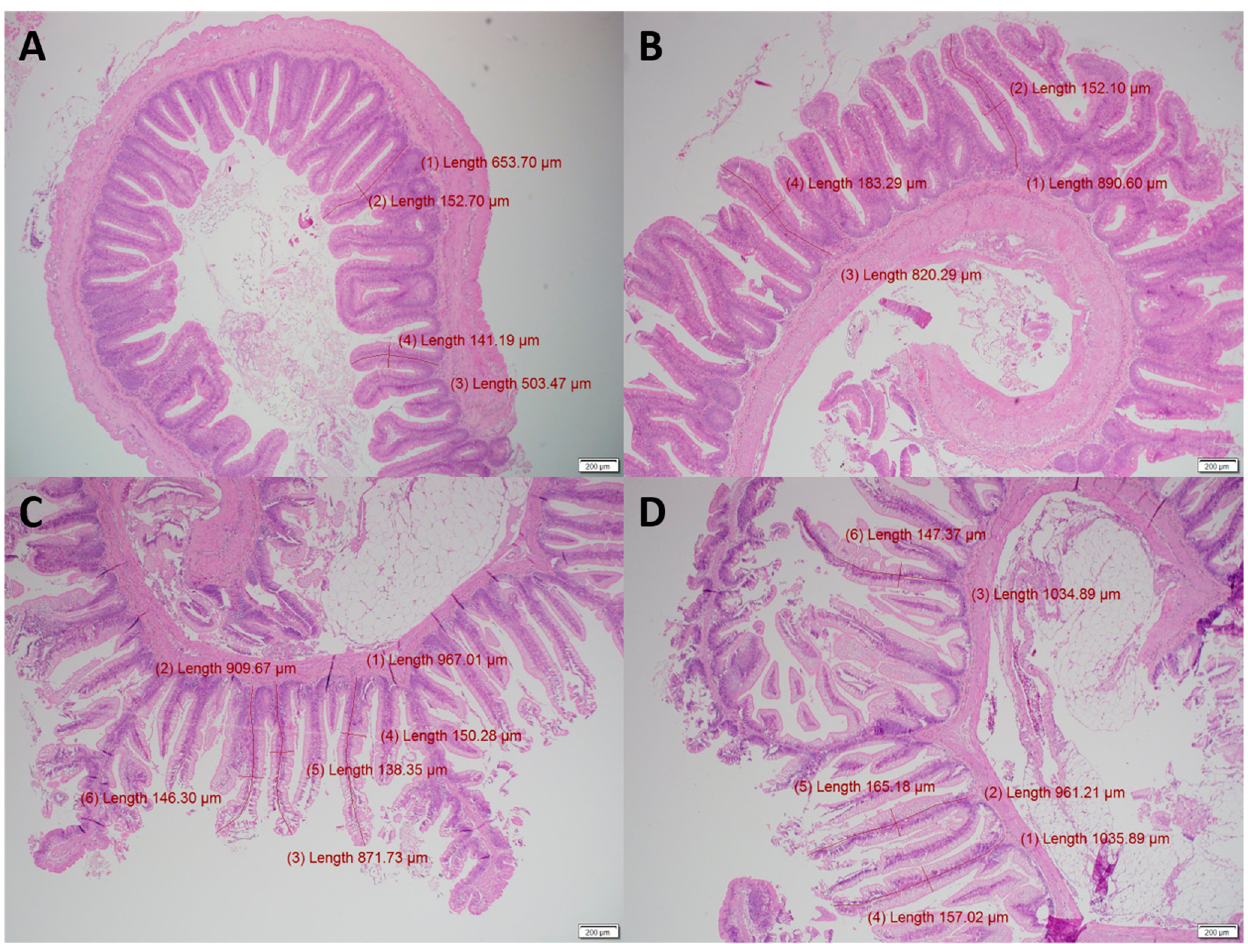
Figure 1. Histology slides of the proximal ( A , B ) and distal ( C , D ) intestine of rainbow trout fed the Control ( A , C ) and Treatment ( B , D ) diets. An example of inflammation of the lamina propria found in the Control group (left), but not the Treatment group (right). Villi length measurements are in red and were significantly longer ( p < 0.05) in the proximal intestine of fish fed the treatment diet ( B ) compared to the control ( A ). Table 2. Histology of the proximal and distal intestine of rainbow trout ( n = 9) after feeding the control and treatment diets for four weeks.